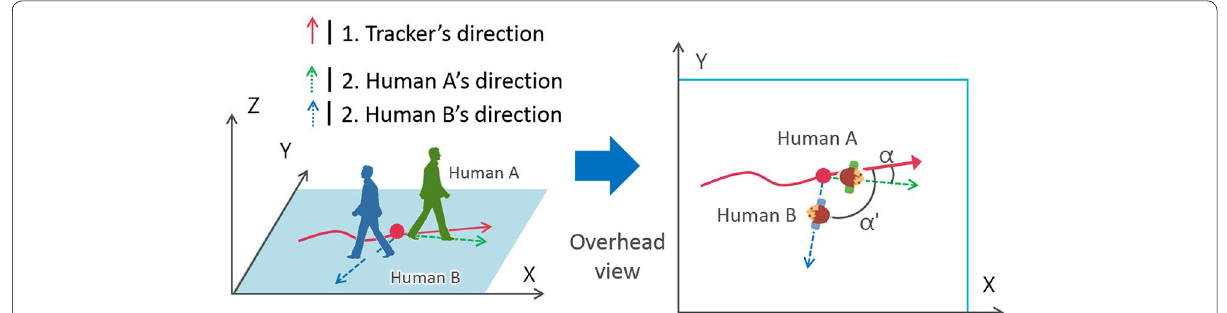
Fig. 6 Angular difference in the traveling directions of humans and